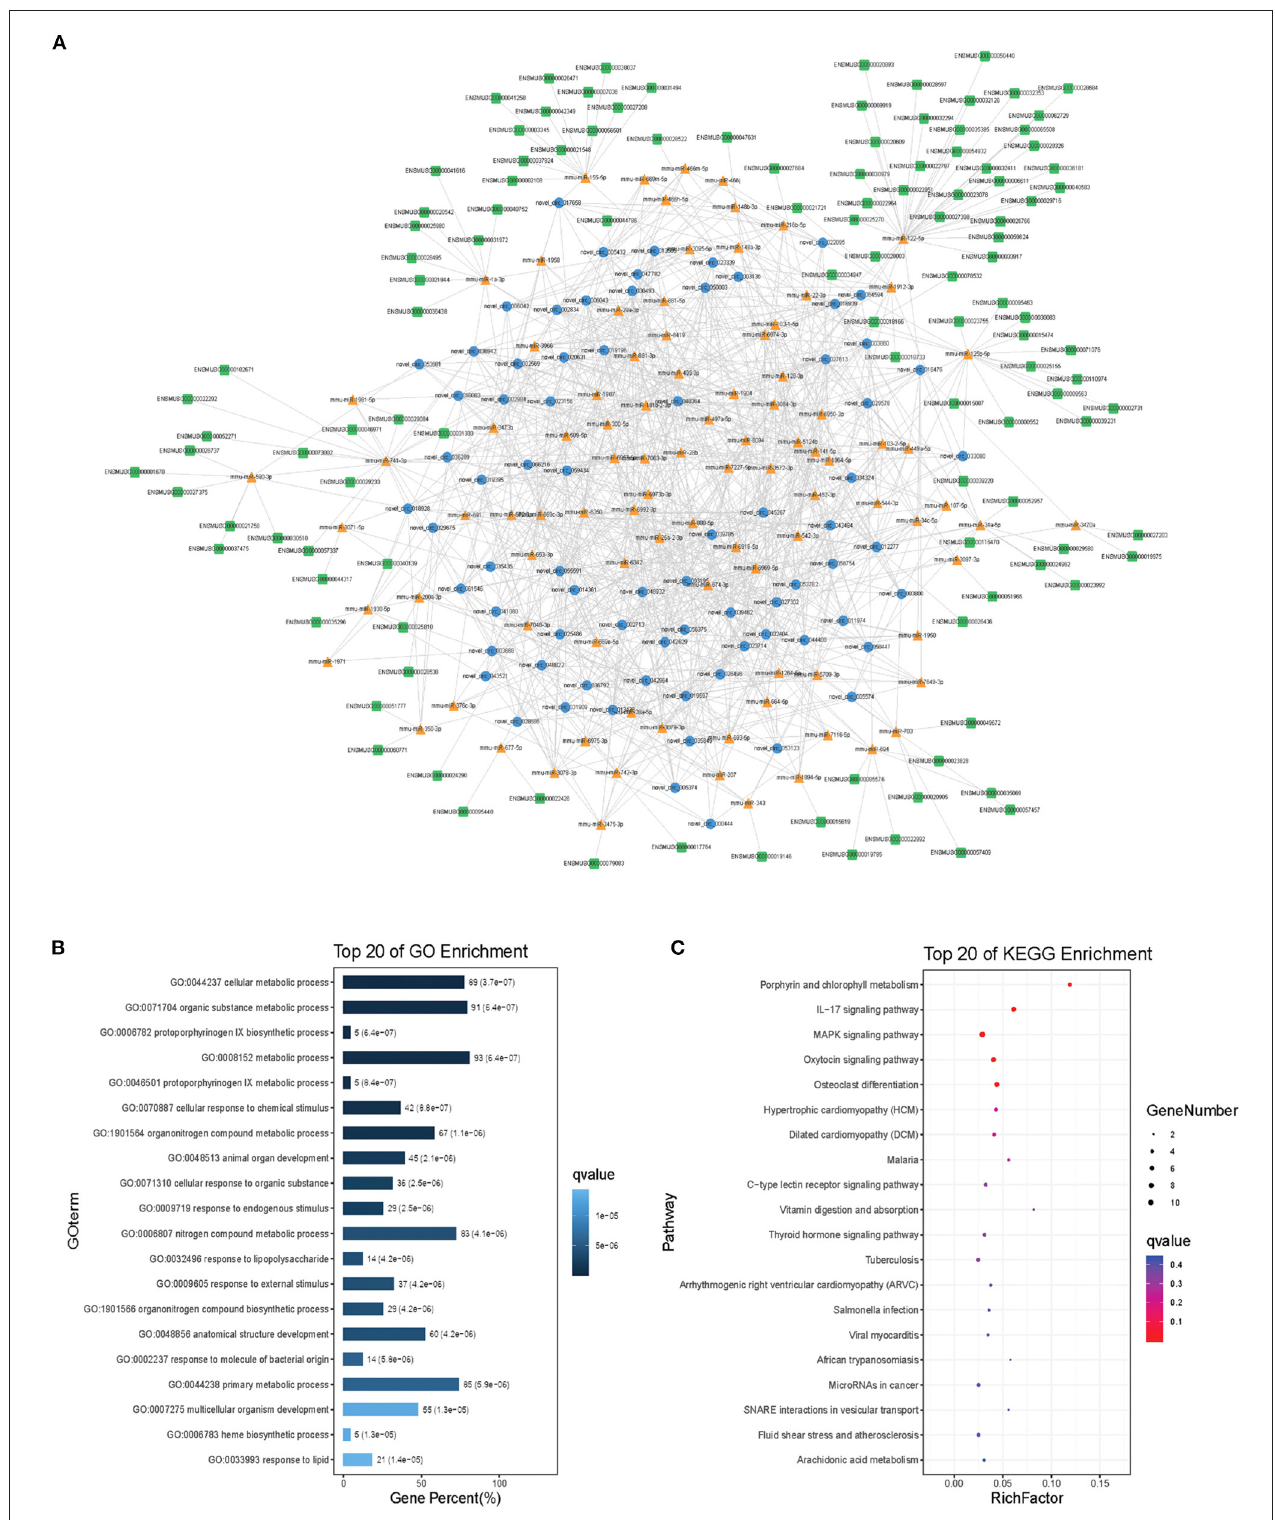
FIGURE 8 | Module 3 from the autism-related ceRNA network. (A) Module 3 network. (B) GO enrichment. (C) KEGG pathway enrichment. Circular blue, triangular orange, and square green nodes represent circRNAs, miRNAs, and mRNAs, respectively.